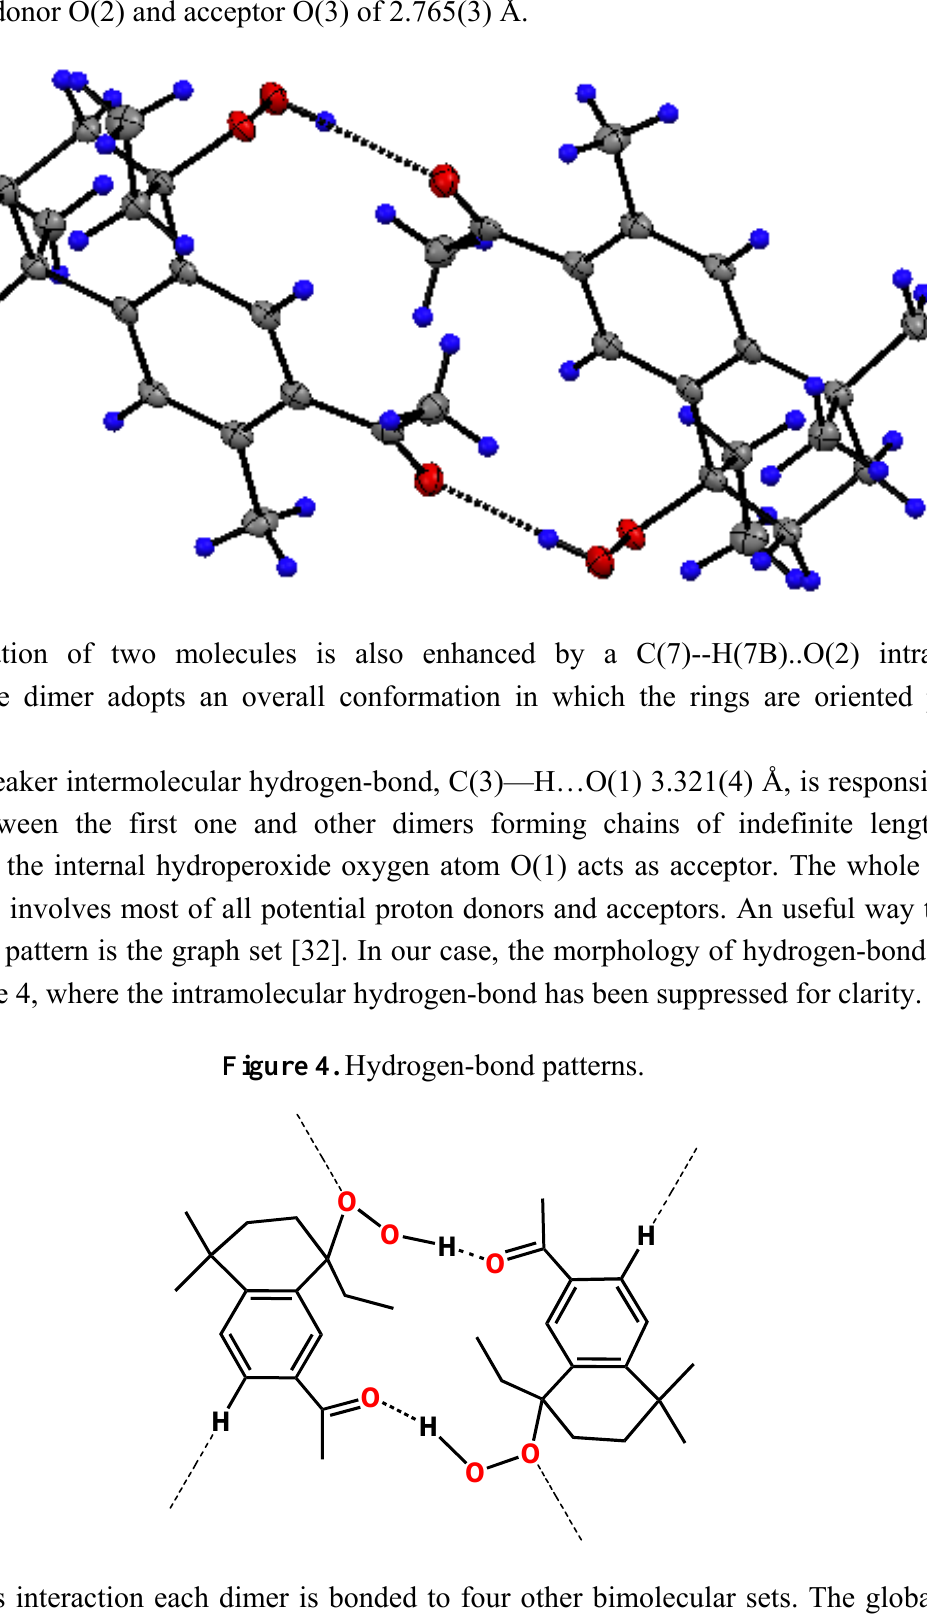
Figure 3. Molecular dimers formed by two hydrogen-bonds with a total bond length between donor O(2) and acceptor O(3) of 2.765(3) Å.